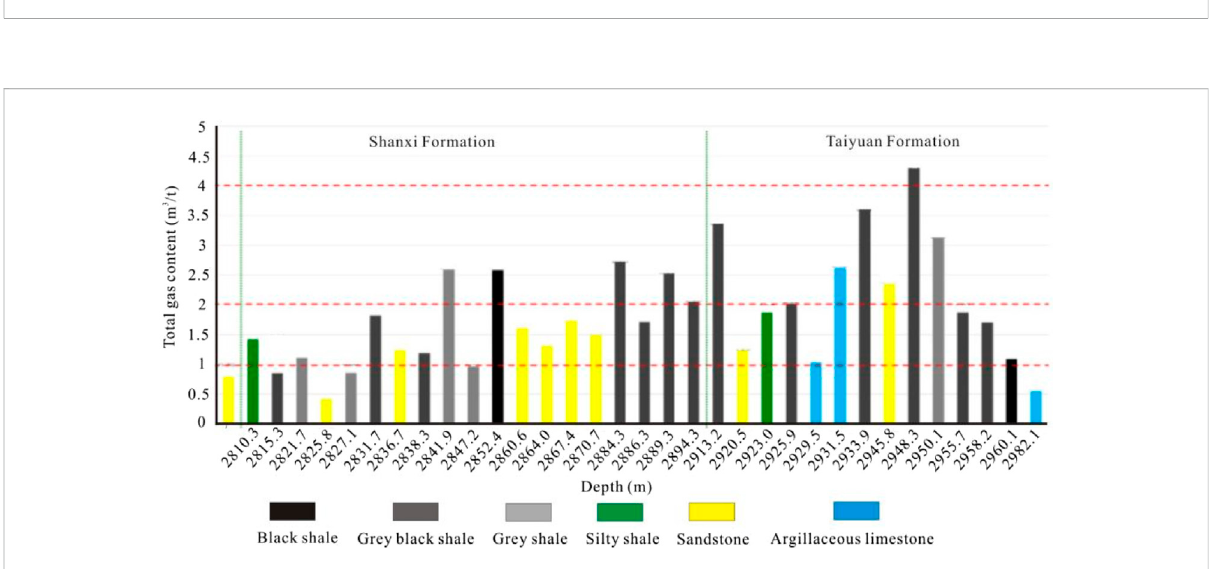
FIGURE 7 Histogram of fi eld analytical total gas content distribution in Well